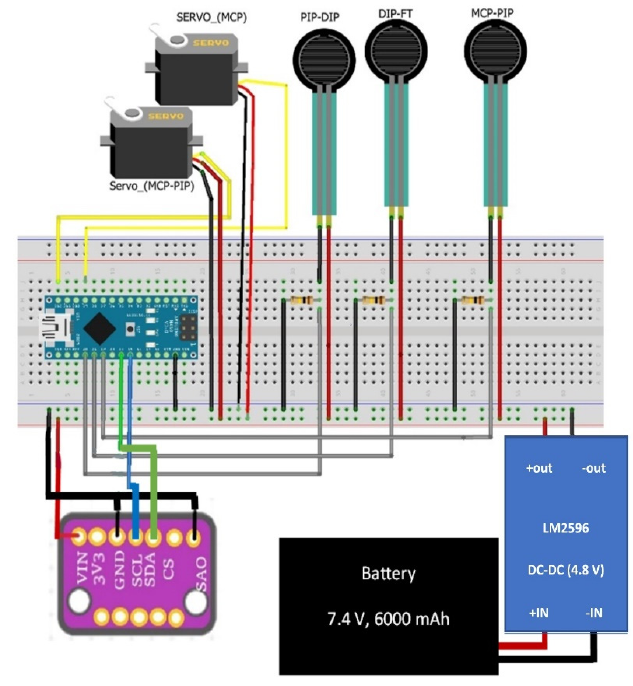
Figure 4. Circuit design for the ExoFinger skeleton.